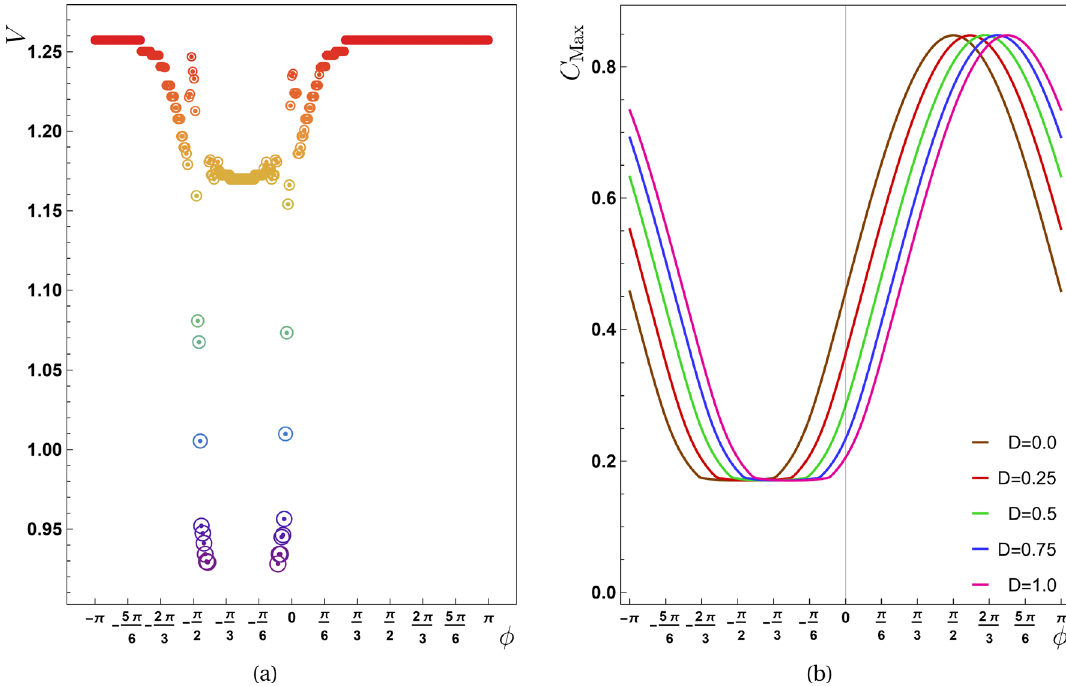
Figure 5. For the third scenario: ( a ) the propagation speed in relation to the phase factor ( φ ), and ( b ) the maximum value of the concurrence function for the pair (2, 3) versus φ